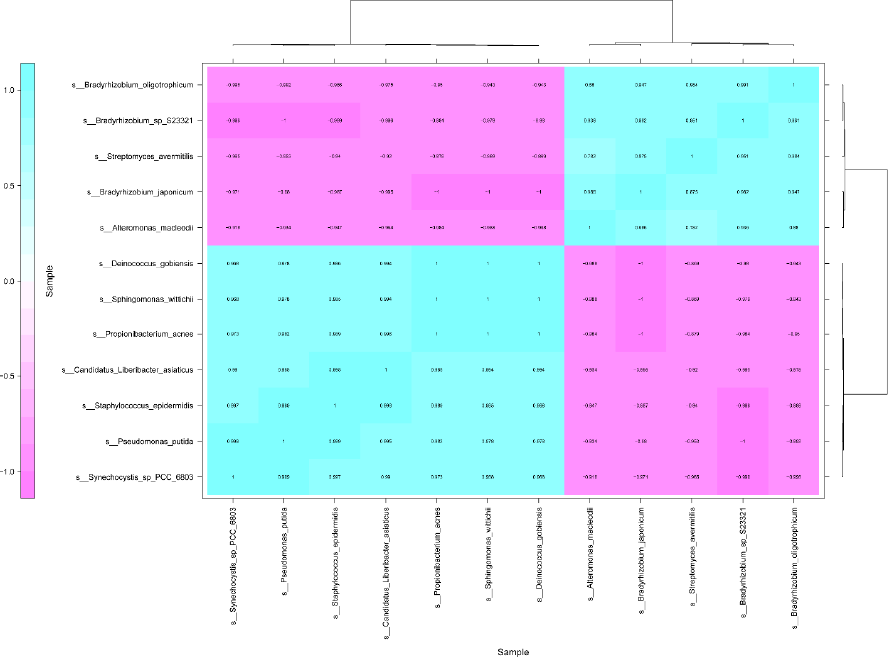
Table 1. Summary of metagenome data.